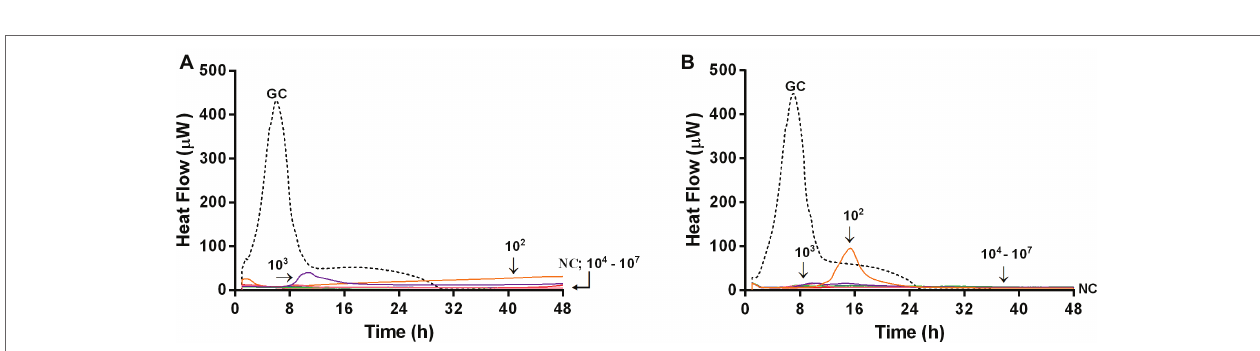
FIGURE 8 | Evaluation of the ability of Sb (A) and PYO (B) phages to prevent biofilm formation on porous glass beads by IMC. Each curve shows the heat produced by viable bacteria potentially attached on the glass beads after 24 h co-incubation with increasing titers of phages (ranging from 10 2 to 10 7 PFU/ml) in the presence of the abiotic surface. Numbers above curves represent Sb titers (in PFU/ml). GC, growth control (dashed line); NC, negative